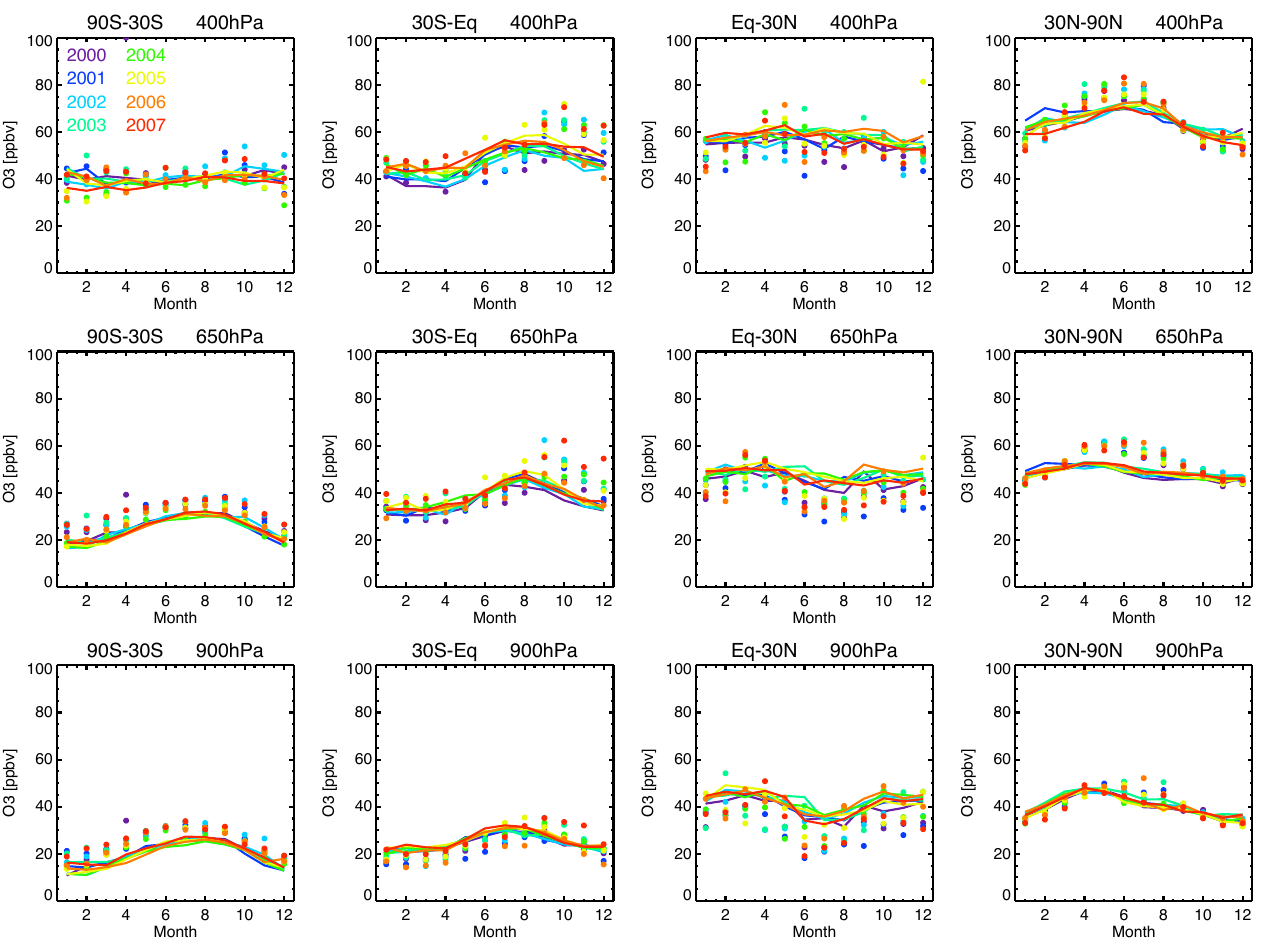
Fig. 8. Evaluation of MOZART-4 with ozonesonde measurements, binned by latitude and altitude, for each year 2000–2007. The number of sites in each region is 90S–30S: 5, 30S–Eq: 10, Eq–30N: 6, 30N–60N: 21. The sites used for each region are given in Table 11. Each dot indicates the average over the month and all sites in the latitude bin, colored by year. The lines indicate MOZART-4 monthly means, averaged over the ozonesonde